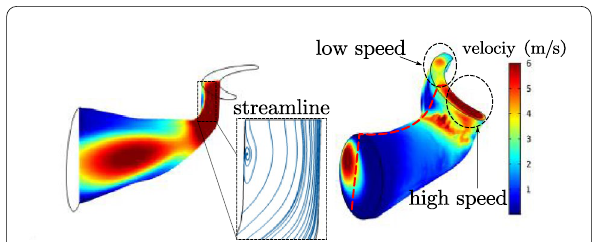
Figure 10 Velocity distribution of the original suction duct